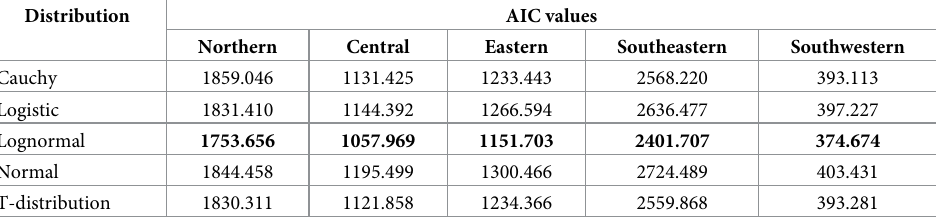
Table 4. AIC results for nonzero rainfall amounts in five